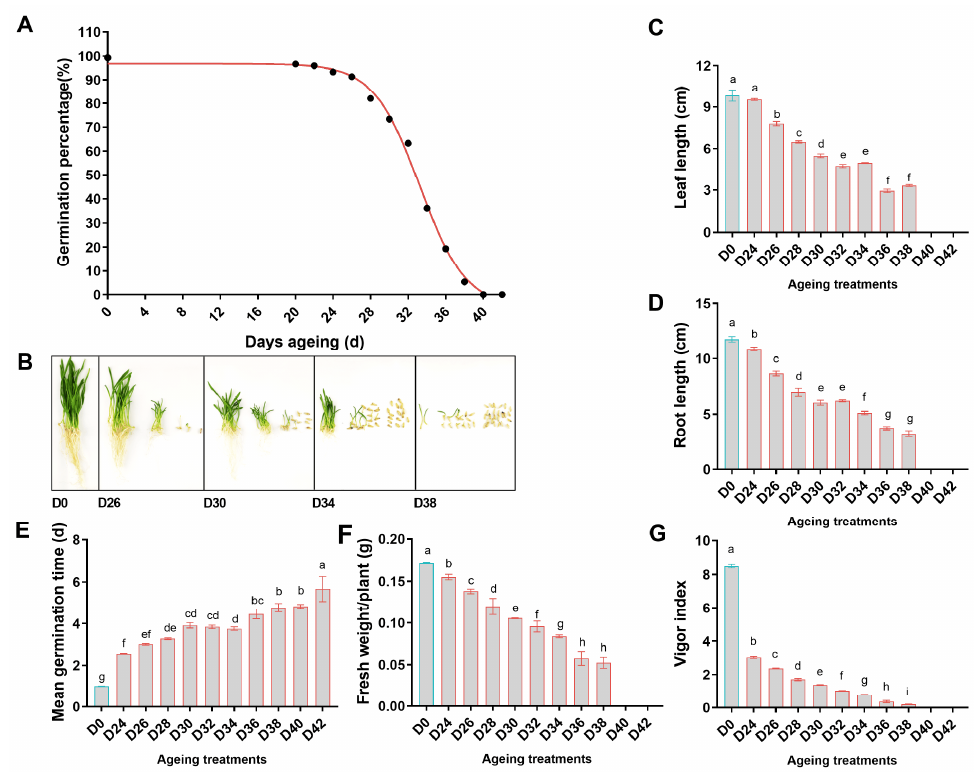
Figure 3. Effect of aging treatments on oat seed germination and seedling growth. ( A ) The declines in the percentages of seeds capable of producing normal seedlings. ( B ) Seeds and seedlings after 10-days germination. ( C – E ) Effect of aging treatments on seedling growth. ( F , G ) Effect of aging treatments on mean germination time and vigor index. D0 represents untreated control seeds. D24–42 represent seeds with 24 to 42 d ageing treatments. The letters represent statistical significance among the treatments and the vertical bars represent the ±SEM at p < 0.05 level for three replicates. The mean values sharing same letters, obtained from Duncan test, are not different significantly.